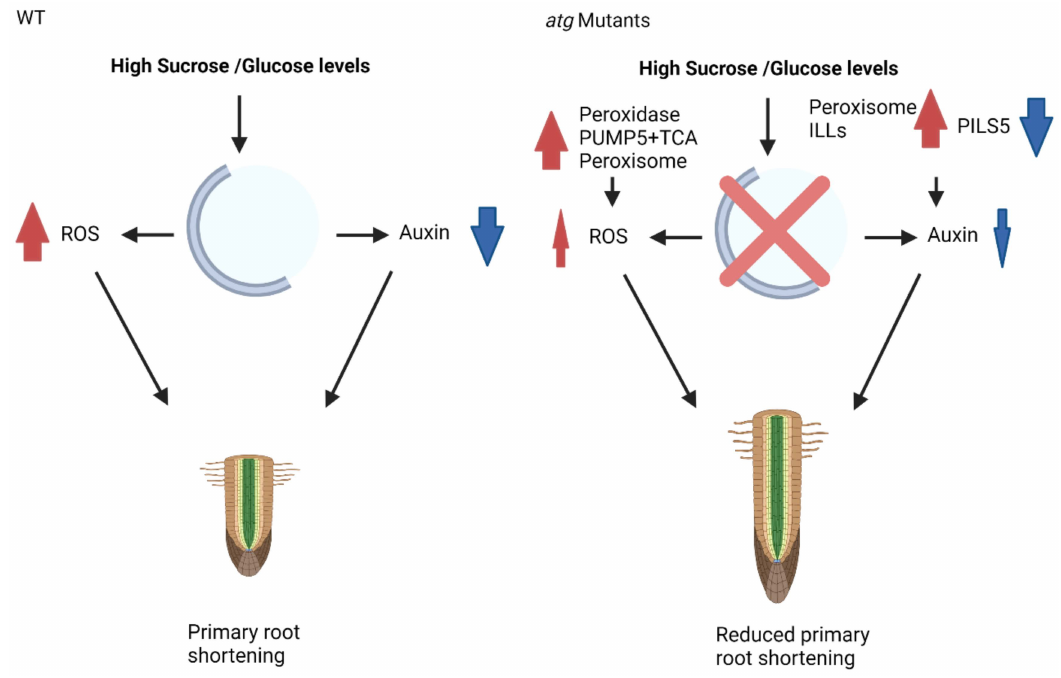
Figure 9. Proposed mechanism of action for autophagy during sucrose excess. In WT plants under high sucrose/glucose levels, primary root shortening occurs via the accumulation of ROS and reduced levels of auxin. In contrast, under similar conditions, atg mutant plants present reduced ROS accumulation, which is mediated via peroxidases, PUMP5, TCA cycle enzymes, and peroxisomal activity. There is also less auxin reduction, which is mediated by peroxisomal proteins and ILL activity. These changes in protein and organellar activity lead to reduced primary root shortening. Red arrows indicate upregulation, blew arrows indicate